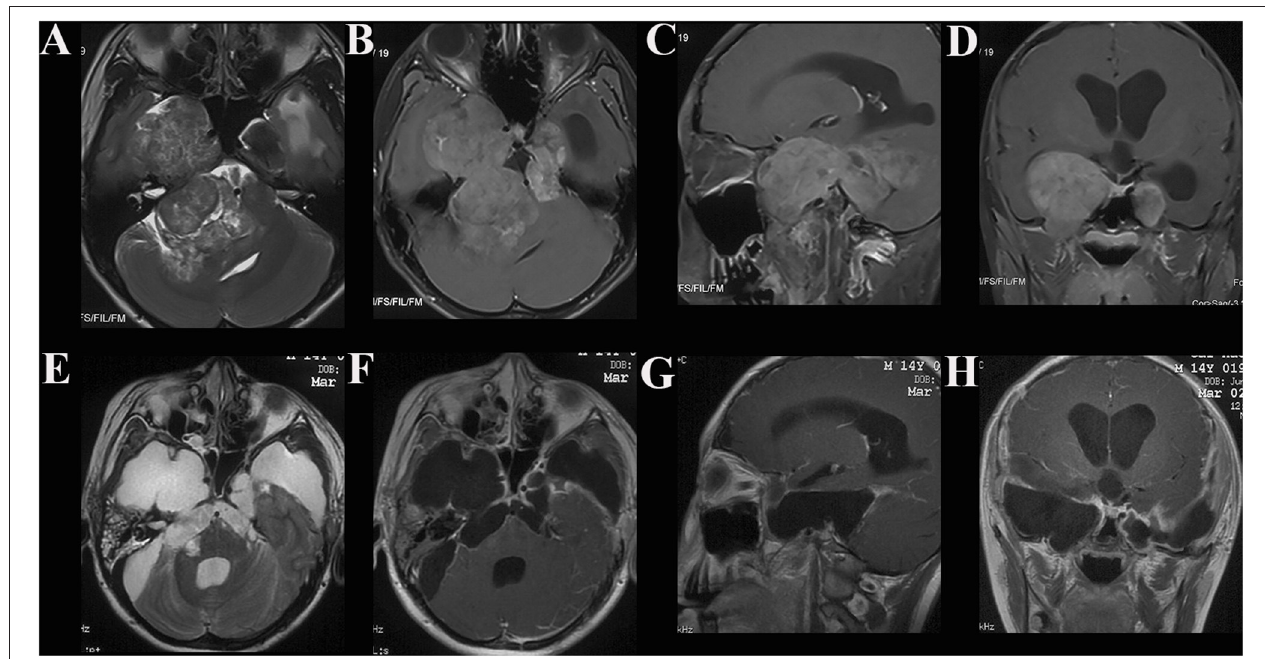
FIGURE 3 | Case illustrating the middle cranial fossa approach. (A) T2-weighted axial MRI show dumbbell shaped tumors in the bilateral middle and posterior cranial base with hyperintense and isointense. (B–D) T1-weighted axial, sagittal, and coronal contrast-enhanced MRIs demonstrate both tumors with heterogeneous enhancement, the dumbell shaped tumor on the right extended into infratemporal fossae (B) . (E–H) Postoperative contrast-enhanced MRI indicated satisfactory tumor resection.